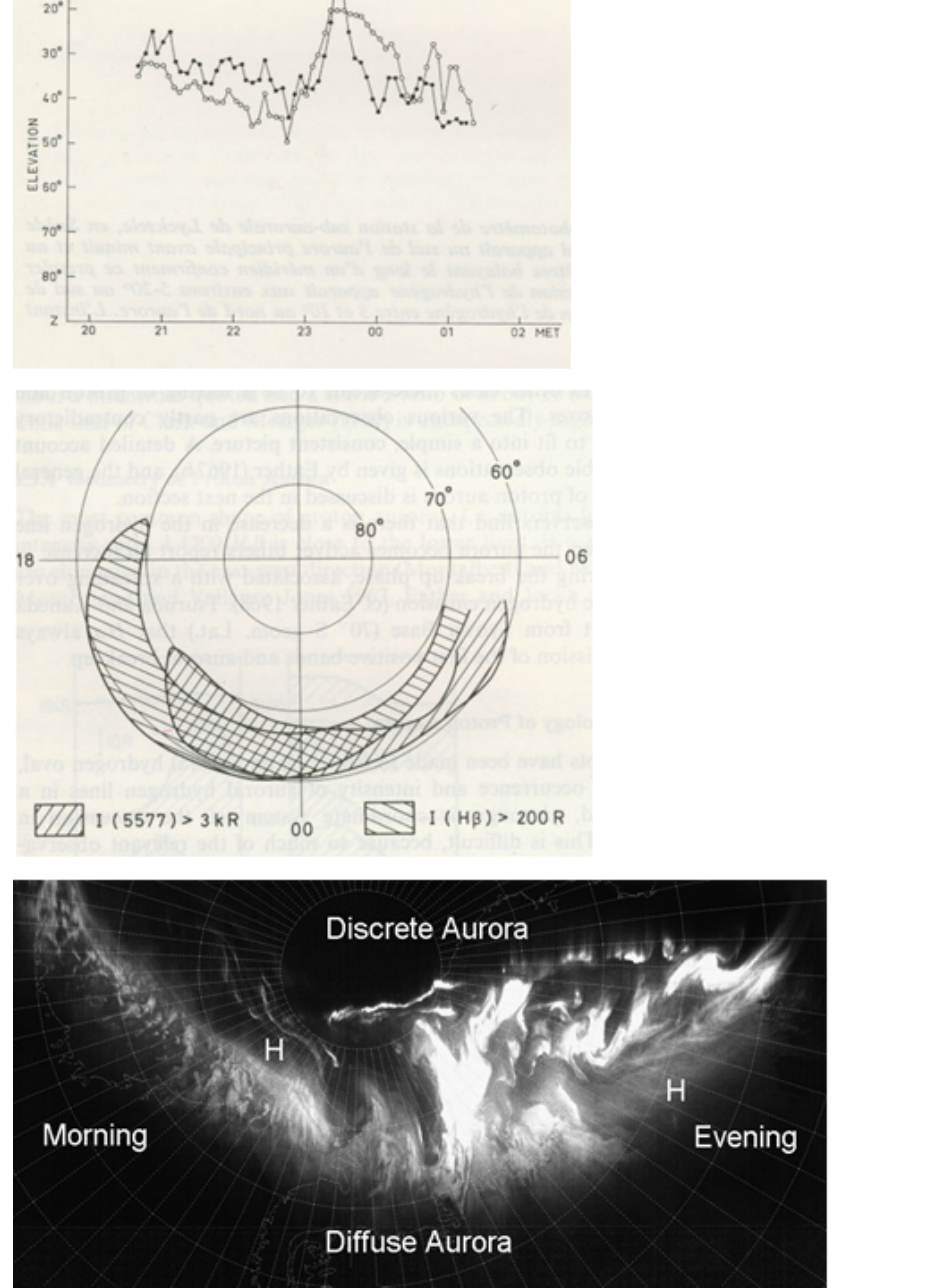
Figure 8. (a) Elevation angles with respect to local zenith ( ◦ ) and intensities of the auroral green line at 557.7nm (closed circles) and H β emissions (open circles) plotted as functions of mean European time (MET) for the night of 19–20 March 1966. Magnetic midnight is close to 23 MET. Data were recorded in northern Scandinavia, close to the rocket range at Andøya, under disturbed magnetic conditions (Omholt, 1971). (b) Average pattern of H β aurorae with intensities > 200 R and electron (557.7nm) aurora during disturbed magnetic activity ( K p > 4) projected onto a magnetic latitude versus magnetic local time grid. The plots summarize nightside photometric and spectrometric data accumulated over several years in the 1950s and 1960s. The crossover in latitude occurs near magnetic midnight (Omholt, 1971). (c) This synoptic image of nightside aurora shows the relative location of the hydrogen emissions – marked with H – versus the oval, in both the morning (left) and evening (right). On the evening side the Balmer radiations are equatorward of the electron aurora, while on the morning side (left) the opposite is the case (courtesy of C. S.